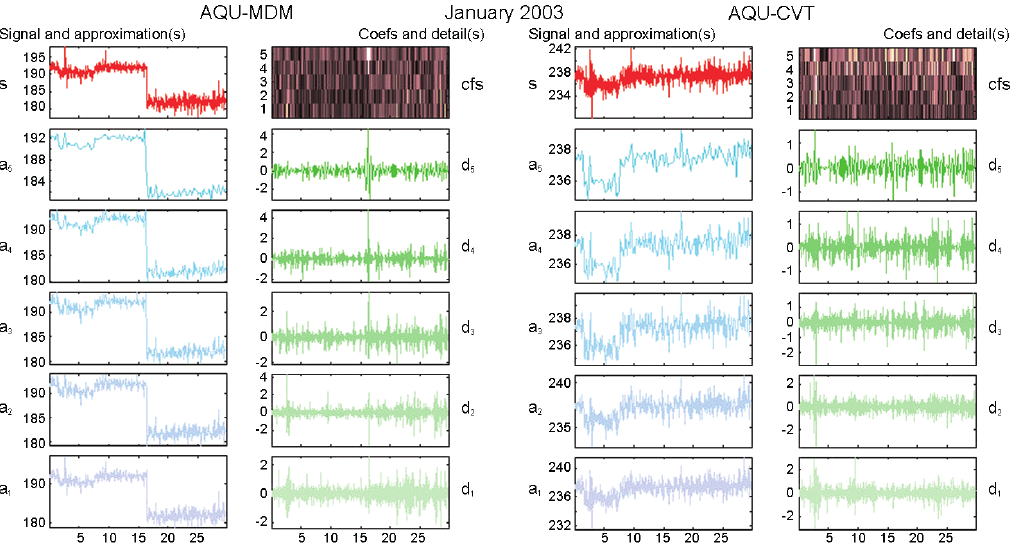
Fig. 6. A decomposition of the differences AQU-MDM and AQU-CVT for January 2003 by means of «db3» wavelet at level 5 applied on one month of data (January 2003).